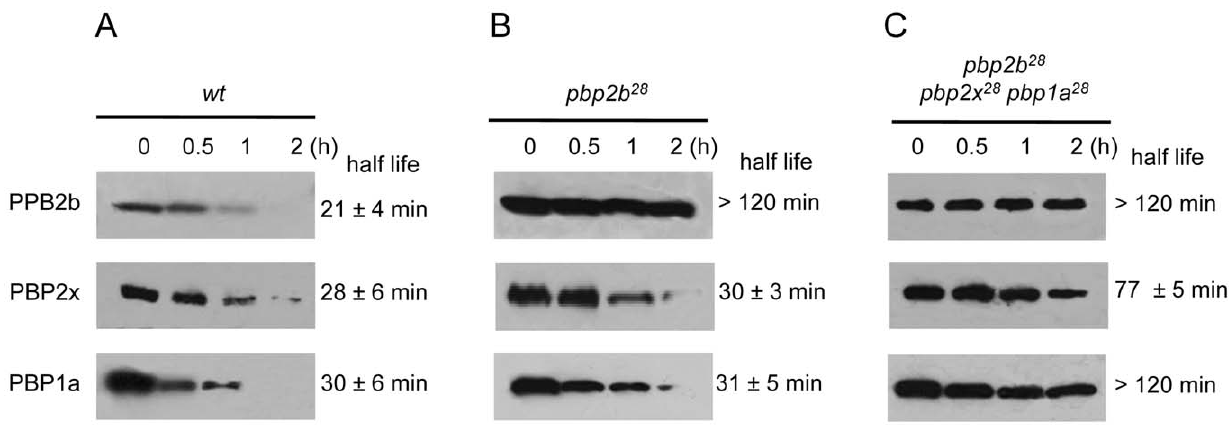
Figure 5. S tability in vivo of wild-type and mutant PBPs. Strains Cp1015 (Panel A), Cp1015 pbp2b 28 (Panel B) and Cp1015 pbp2b 28 pbp2x 28 pbp1a 28 (Panel C) expressing HA-tagged PBPs were grown in Todd Hewitt broth with 0.5% Yeast Extract to an OD 600 nm of 0.2 prior to the addition of kanamycin (500 m g/ml) to inhibit protein synthesis. At the time intervals indicated, aliquots were withdrawn and analyzed by SDS-PAGE followed by immunoblotting with an anti-HA monoclonal antibody (see Material and Methods).